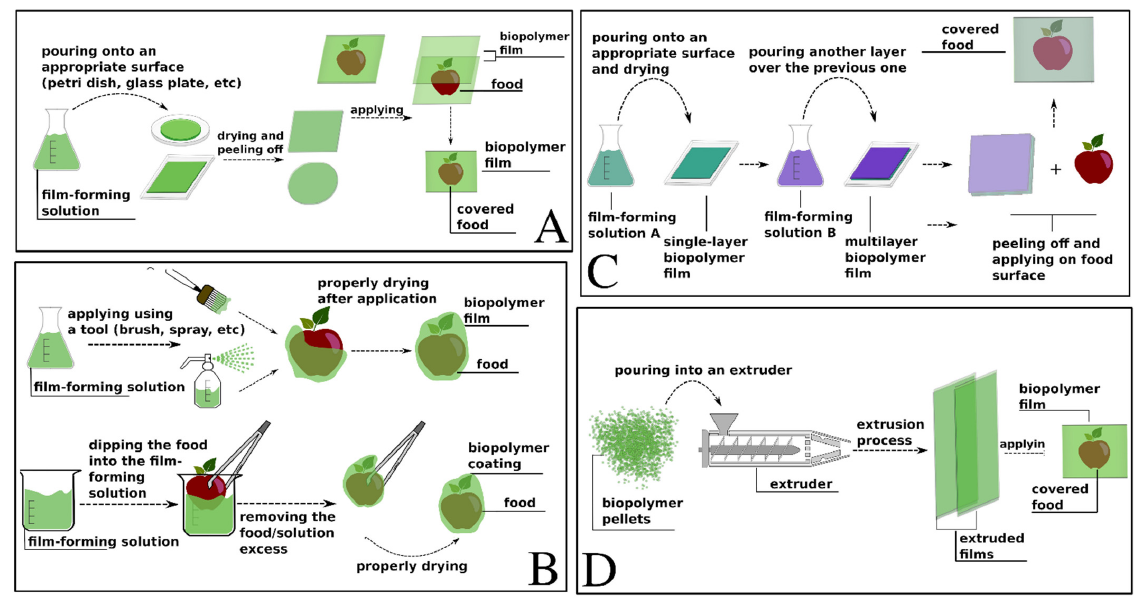
Figure 2. Conventional methods for the production of bio-based films. ( A ) Solution casting. ( B ) Coating. ( C ) Layer-by-layer assembly. ( D ) Extrusion.